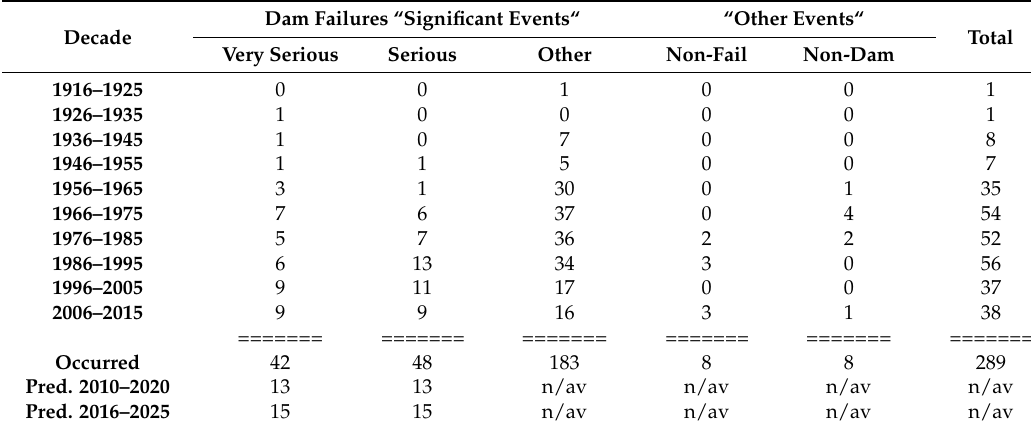
Table 2. TSF Related Failures & Events by Severity